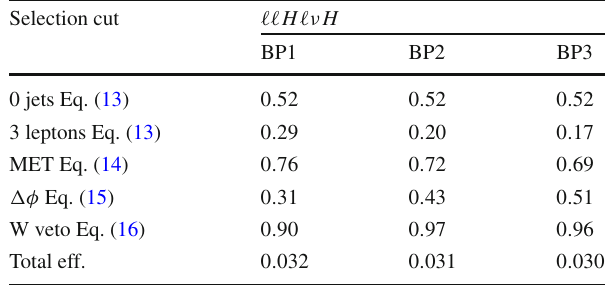
Table 7 Signal selection efficiencies and the total efficiency Selection